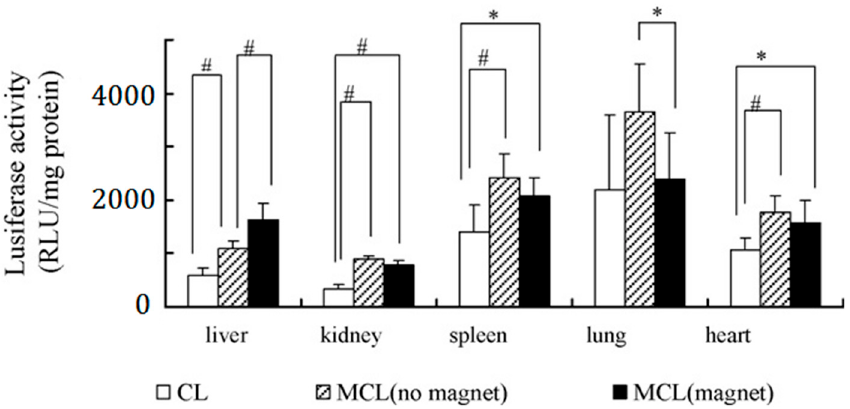
Figure 4. Effect of external magnetic field on the transfection activity of MCLs/pDNA nanoformu- lations in vivo. The concentration of MAG-T in the MCLs was 1.5 mg/mL and the weight ratio between MCLs and pDNA was 8.0. Luciferase activity was determined 24 h post-injection in the liver, kidney, spleen, lung, and heart, respectively. Each value represented mean ± S.D. ( n = 6). * p < 0.05, # p < 0.01. Adapted with permission from [50].